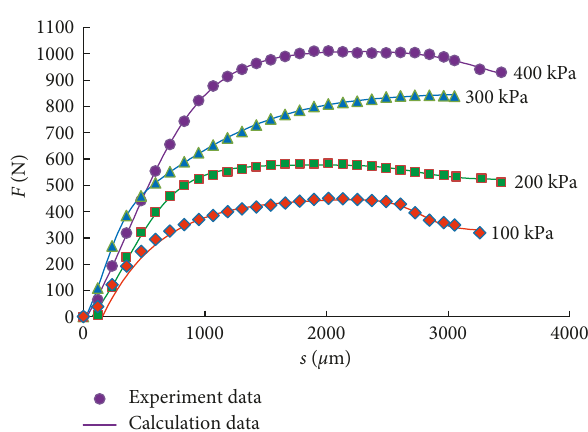
Figure 7: F-s fitting curve of iron tailing powder with 4%